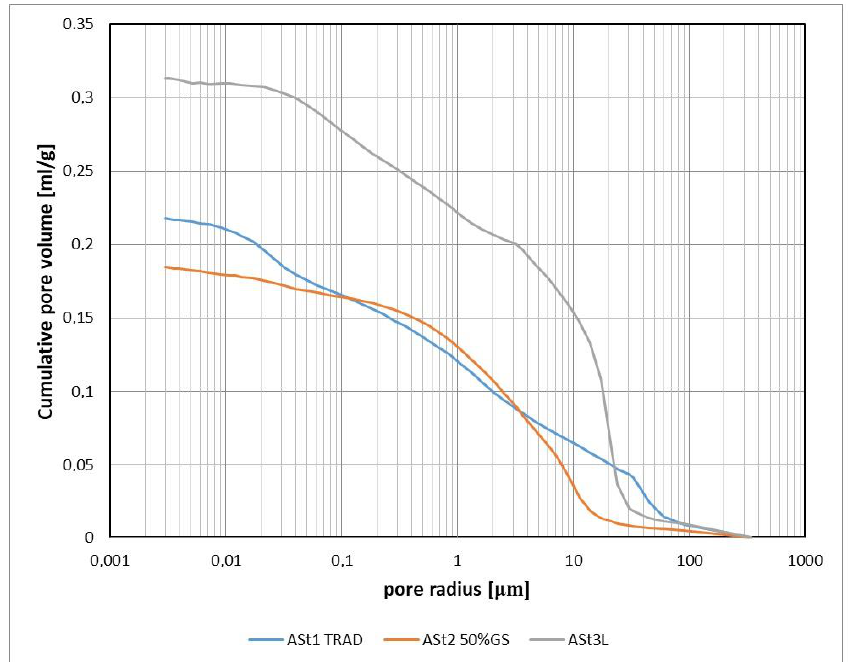
Figure 20. The cumulative volume of pores in the samples of silicate material: traditional (blue color), modified with 50% glass sand and 50% quartz sand (red color) and the material fully modified (90%) with glass sand (gray color).